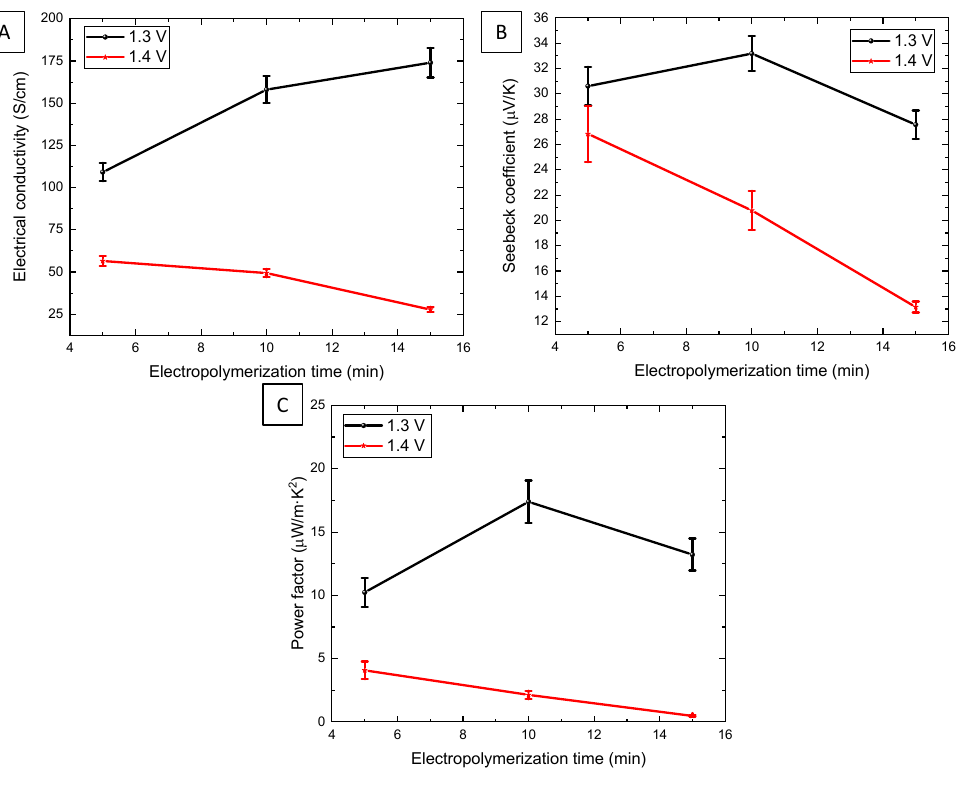
Figure 4. Thermoelectric properties: ( A ) the electrical conductivity, ( B ) the Seebeck coefficient, and ( C ) the power factor of PEDOT films grown at different potentials and deposition times. The electrical conductivity increased as the electropolymerization times increased (see Figure 4A) for the films grown at 1.3 V. The values obtained were 109 ± 6, 158 ± 8, and 174 ± 9 S/cm for 5, 10, and 15 min, respectively, while for those grown at 1.4 V, the con ‐ ductivity was observed at half of that obtained at 1.3 V and decreased even more with the deposition time. The values of the electrical conductivity of the films obtained at 1.4 V were 57 ± 3, 49 ± 3, and 28 ± 1 S/cm for 5, 10, and 15 min, respectively. The difference in electrical conductivity between the films obtained at 1.3 V and at 1.4 V can be explained by the red shift observed in the Raman spectrum. As was already explained, the red shift of the symmetric C α = C β ( ‐ O) stretching Raman band indicates a change in the PEDOT structure from a benzoid to a quinoid structure [42] (see Figure 5).